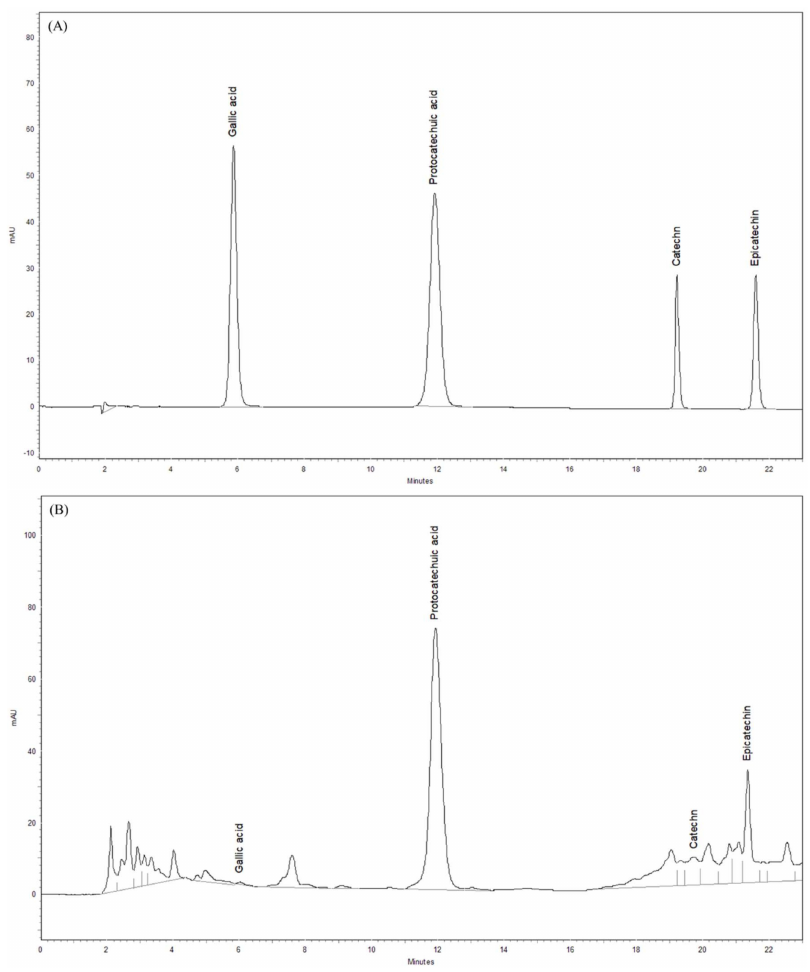
Figure 7. High-performance liquid chromatography (HPLC) chromatograms of ( A ) standards and ( B ) Sophora tomentosa extract at 272